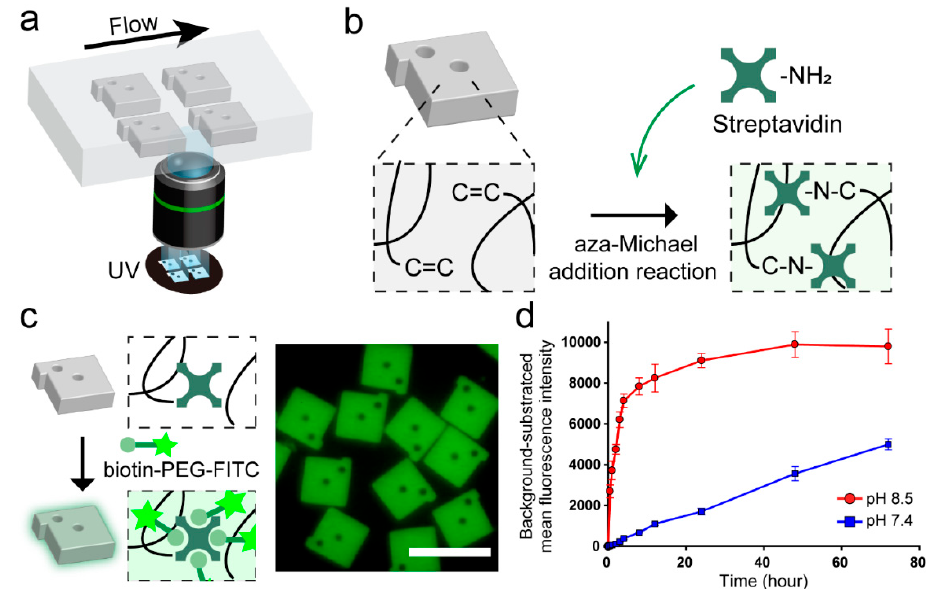
Figure 1. Schematic representation of the synthesis of streptavidin-conjugated encoded hydrogel microparticles and optimization of the streptavidin conjugation process. ( a ) Synthesis of hydrogel microparticles by stop flow lithography (SFL). ( b ) Conjugation of streptavidin using the aza-Michael addition reaction between the unreacted double bonds remaining in the hydrogel microparticles and primary amine groups in streptavidin. ( c ) Schematic view of streptavidin identification using biotin–PEG–FITC (left) and fluorescence micrograph of streptavidin-conjugated encoded hydrogel microparticles (right). Scale bar is 100 µ m. ( d ) Optimization of streptavidin conjugation versus pH of the mixture and reaction time.